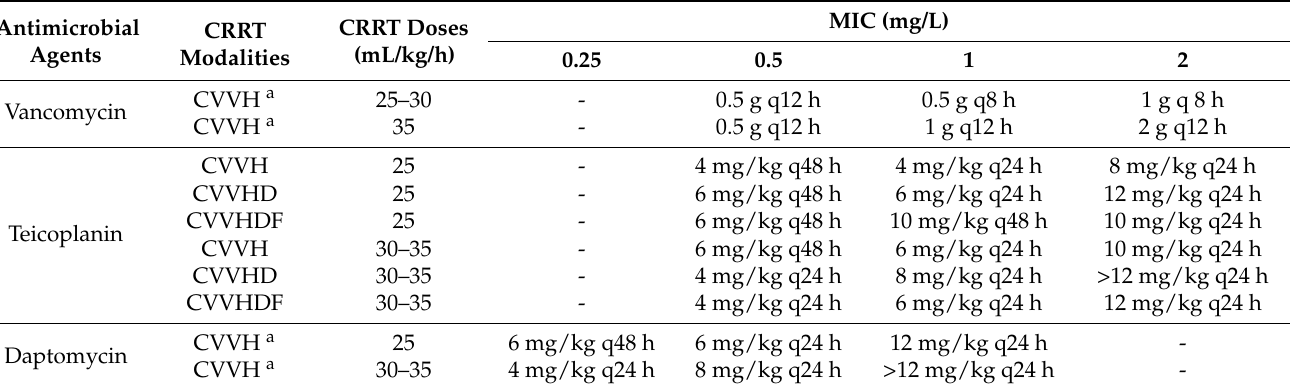
Table 2. The dosage recommendations of three antimicrobial agents for treating MRSA infections with various MICs for critically ill patients undergoing